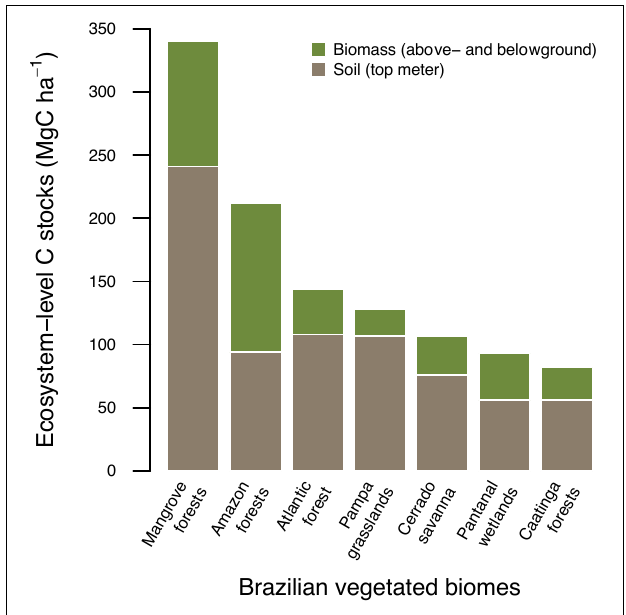
FIGURE 1 | Comparison of ecosystem-level carbon stocks (above-, belowground biomass and soil organic carbon in the top 1 meter combined) among major Brazilian vegetated